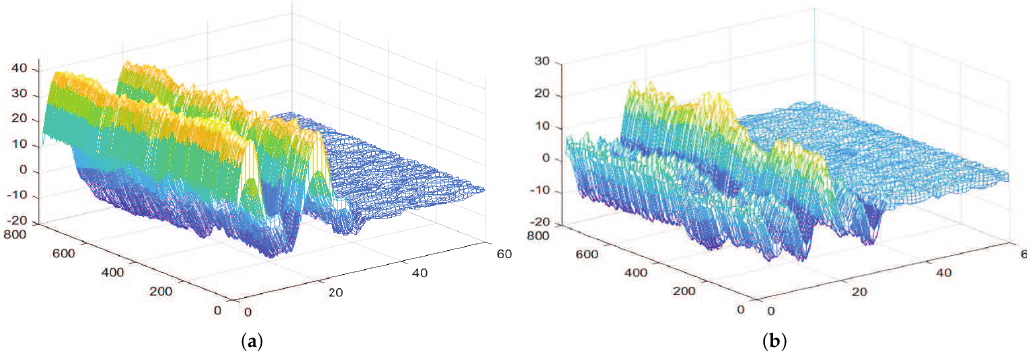
Figure 6. Comparison of output of convolution layer and Inception module for letter ‘M’ and ‘m’. ( a ) The output of Inception module for uppercase letter ‘M’; ( b ) The output of Inception module for uppercase letter